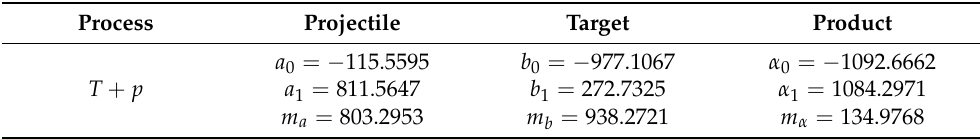
Table 4. Case TBB Solution 2 (in MeV/ c 2 with c set to 1) with Equations (51) and (52) satisfied up to four digits after the decimal shown. See text for